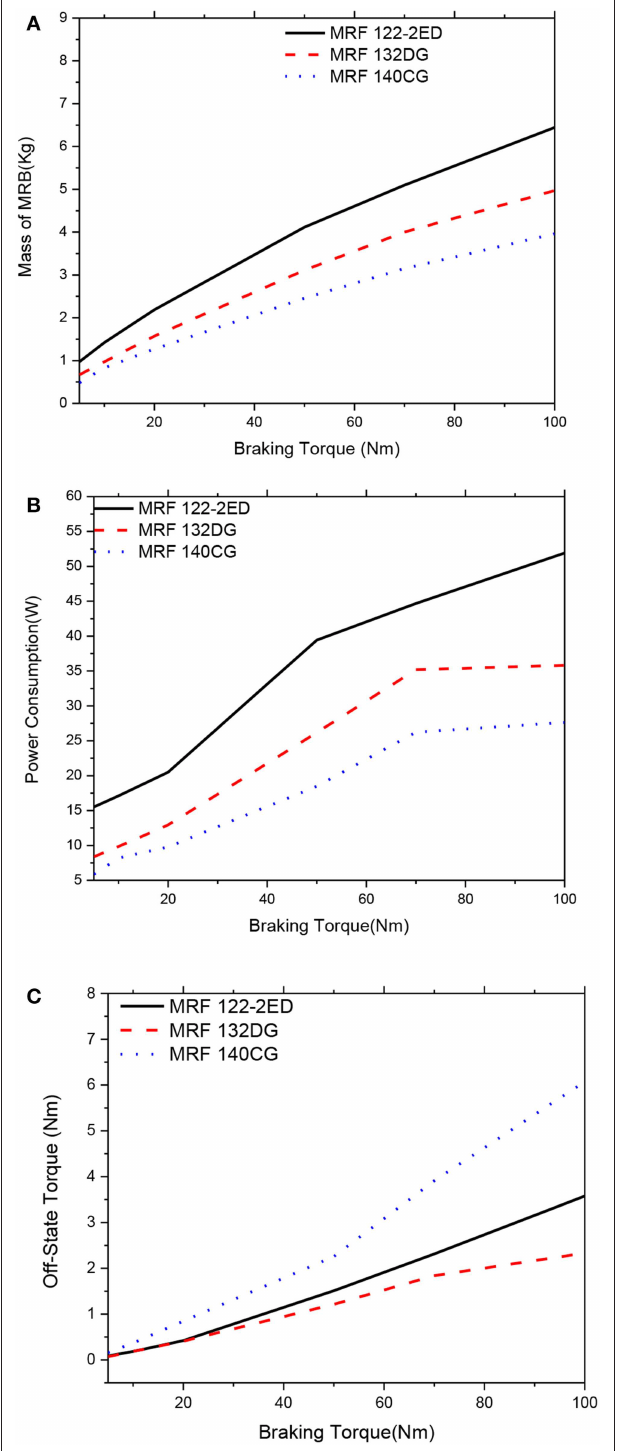
FIGURE 9 | Mass optimization results of the MRBs as a function of braking torque of side-coil MRB, d = 0.8mm. (A) Mass as a function of braking torque, (B) Power consumption as a function of braking torque, (C) Off-state torque as a function of braking torque.